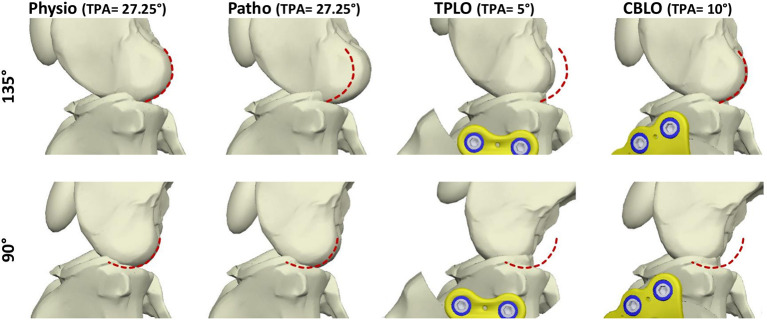
Initial (top) and final (bottom) relative positions between the femur and the tibia, for the four considered models, during the squat simulations. The different configurations are aligned referring to the tibial plateau. Red dashed lines report the femoral condyle position in the physiological case.